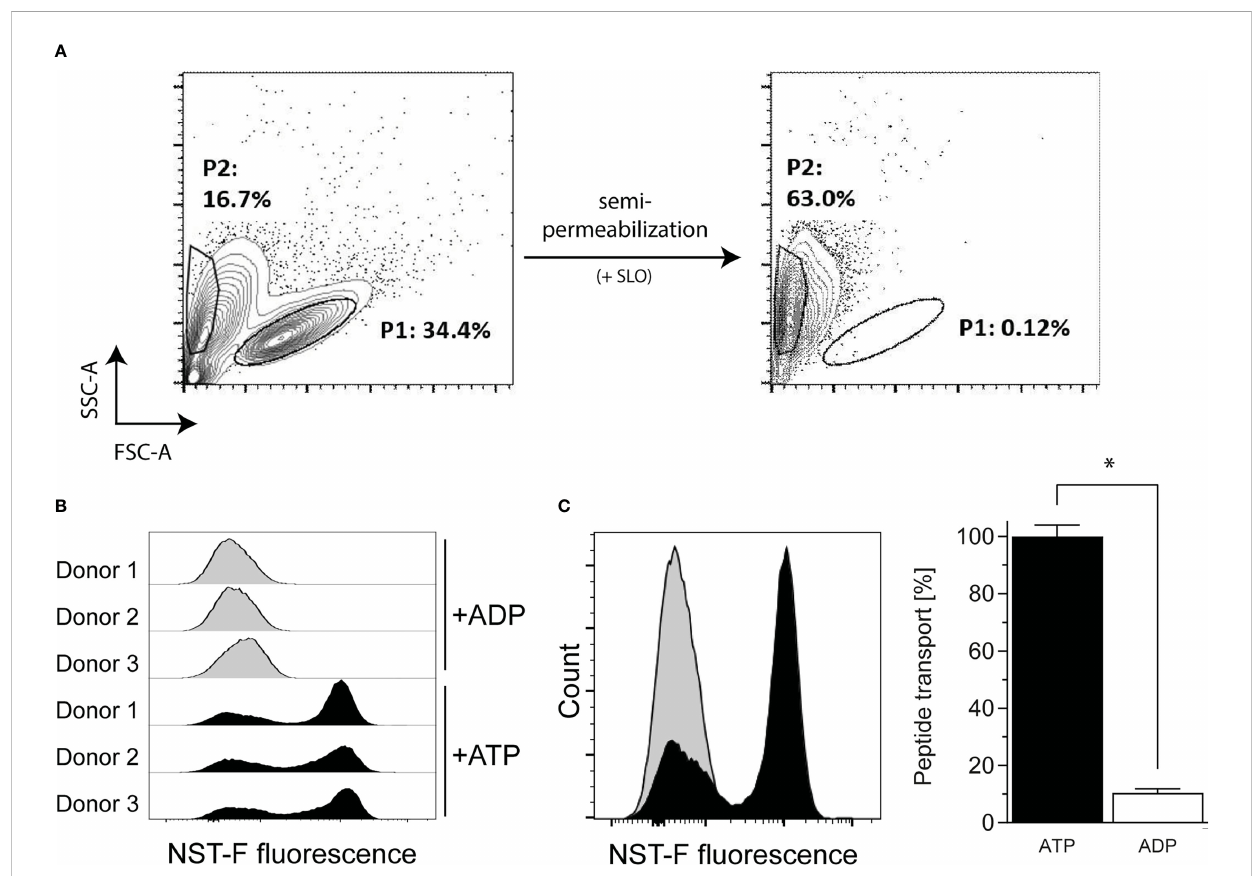
FIGURE 2 TAP-dependent peptide translocation assay in B-LCLs to monitor TAP-dependent antigen translocation by fl ow cytometry. B-LCLs resuspended in translocation buffer were (A) semipermeabilized with streptolysin O (SLO) and 10 nM fl uorescein-labelled human histone H3-derived reporter peptide RRYQNSTC (F) L (NST-F) was added. The viable B-LCL population (P1) was shifted in the SSC/FSC scatter plot after semipermeabilization. Apoptotic cells without SLO treatment showed no background transport. Peptide translocation was carried out in the presence of ATP or ADP (10 mM each). ATP-dependent compartmentalization of NST-F shown as mean fl uorescence intensity (MFI) of the fl uorescein channel for ATP versus ADP sample in (B) histogram overlay of the single-cell events for all tested samples and as (C) histogram overlay for one representative result and as mean relative translocation rate (%, ATP: black bar versus ADP: white bar). Results of three independent experiments are expressed as mean ±